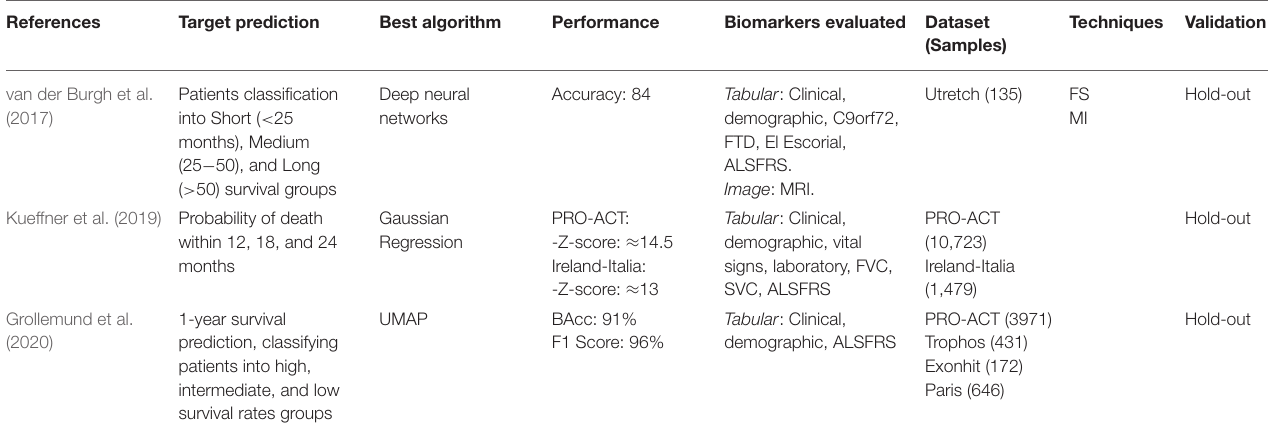
TABLE 7 | Overview of ML approaches on survival time.